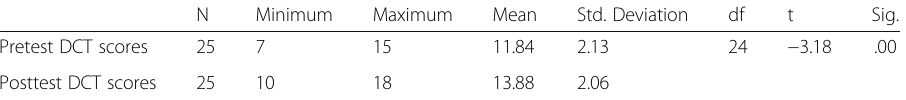
Table 6 Paired-samples t-Test Results Comparing the DCT Scores on the Pretest and